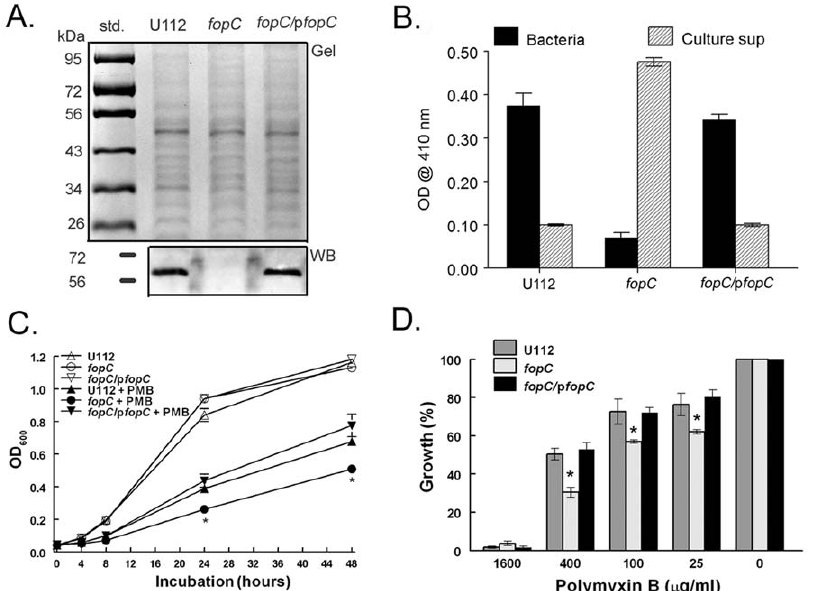
Figure 7. Acid phosphatase activity and resistance to polymyxin B treatment are restored in a fopC- complemented strain. (A) U112, fopC mutant and complemented fopC /p fopC cell lysates were separated by 10% SDS-PAGE and either stained with Coomassie blue (Gel) or transferred onto a PVDF membrane and probed with polyclonal FopC antisera (WB). (B) U112, fopC and fopC /p fopC were grown for 36 h in Chamberlain’s medium. Bacteria and respective concentrated (60 fold) culture filtrates were analyzed for acid phosphatase activity using p - nitrophenylphosphate substrate. (C) Growth curves of U112, fopC mutant and complemented fopC /p fopC cells in Chamberlain’s medium 6 polymyxin B (400 m g/ml) over 48 h. *Difference in growth between fopC mutant and U112/complement strain was significant at a p , 0.01 (D) Inhibition of U112, fopC mutant and complemented fopC /p fopC cell growth in Chamberlain’s medium at 24 h by various concentration of polymyxin B. Bacterial growth in the presence of polymyxin B is presented as % to corresponding bacterial strain grown in the absence of polymyxin B. *Difference in growth between fopC mutant and U112/complement strain was significant at a p , 0.01. (Representative of two experiments with triplicates for